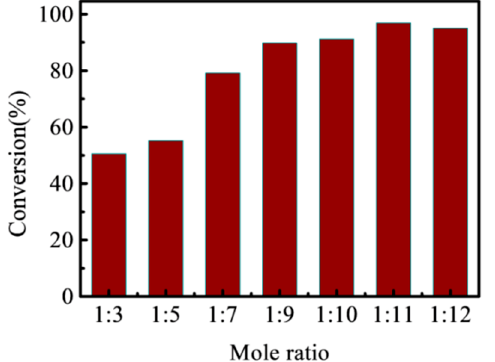
Figure 10. Effect of Acid: Alcohol Mole Ratio on the esterification of levulinic acid with n-butanol operated at reaction temperature: 90 °C, reaction time: 5 h, catalyst mass: 0.116 g, and acid: Alcohol ratio: 1:3, 1:5, 1:7, 1:9, 1:10, 1:11, and 1:12.